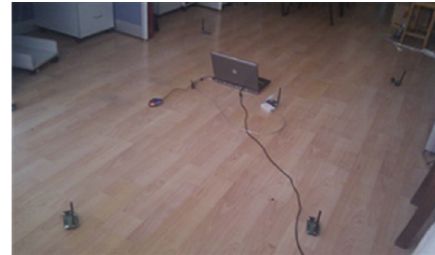
Fig. 2 Tracking environment for our indoor sensor